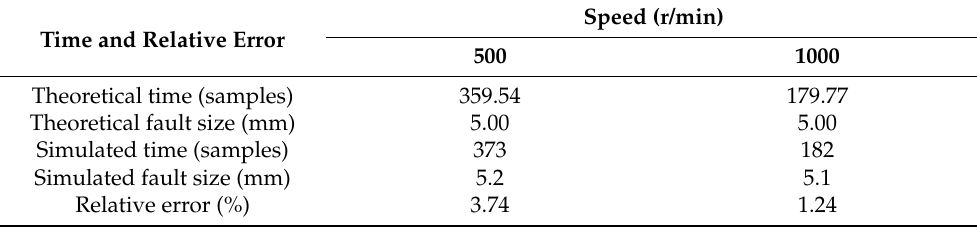
Table 3. Comparisons between the theoretical and measured time of the double